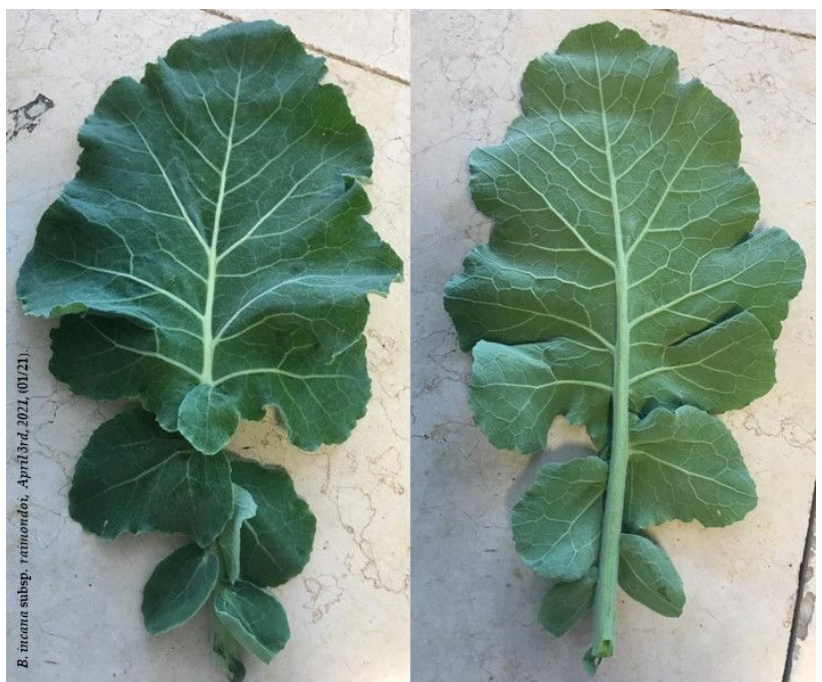
Figure 7. Leaf characteristics and morphology of Brassica incana subsp. raimondoi (Sciandr., C. Brullo, Brullo, Giusso, Miniss. and Salmeri) used in this research.